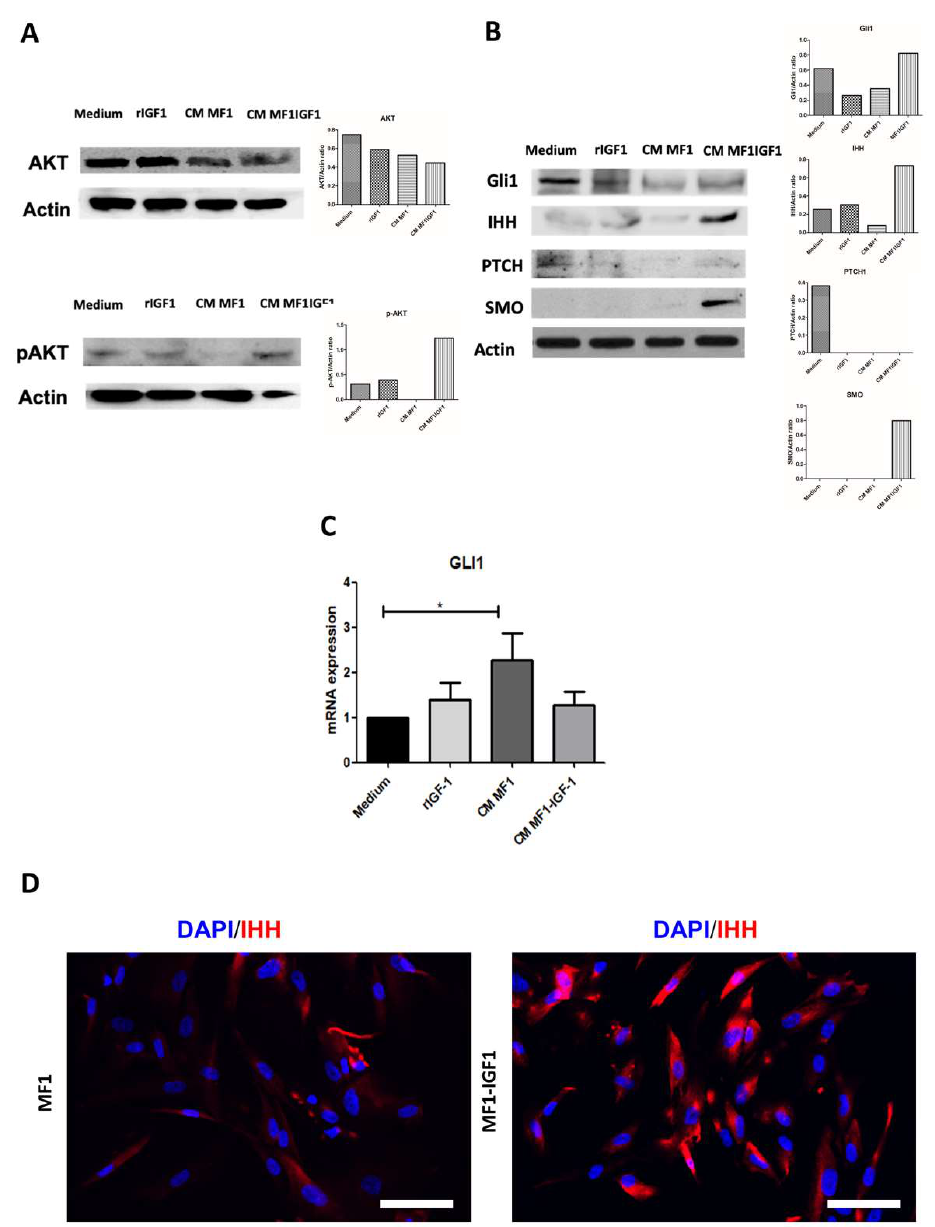
Figure 2. Regulation of AKT and HH pathways in SCC-4 by stimulation with IGF-1 or fibroblast-conditioned media. SCC-4 cells were stimulated for 24 h with 10% FBS, 100 ng / mL rIGF-1 or 50% conditioned medium from control fibroblasts (MF1) or cells overexpressing IGF-1 (MF1-IGF-1). Western blot analysis was performed to detect ( A ) total AKT and phospho-Akt (S473), with band intensity measured and plotted using ImageJ; ( B ) GLI1, IHH, PTCH1 and SMO band intensities were measured and plotted using ImageJ; ( C ) GLI1 mRNA expression was evaluated by RT-qPCR 6 h after stimulating cells with rIGF-1 or conditioned media. Data are presented as means ± SDs, bars represent comparisons between respective groups and (*) denotes statistical significance after applying the one-way ANOVA and Dunnett’s post-test, p < 0.05. CM: conditioned medium. ( D ) IHH immunostaining in MF1 and MF1-IGF-1 fibroblasts. The presence of the IHH ligand is shown in red, while nuclei were stained with DAPI (blue). Bars = 50 µ